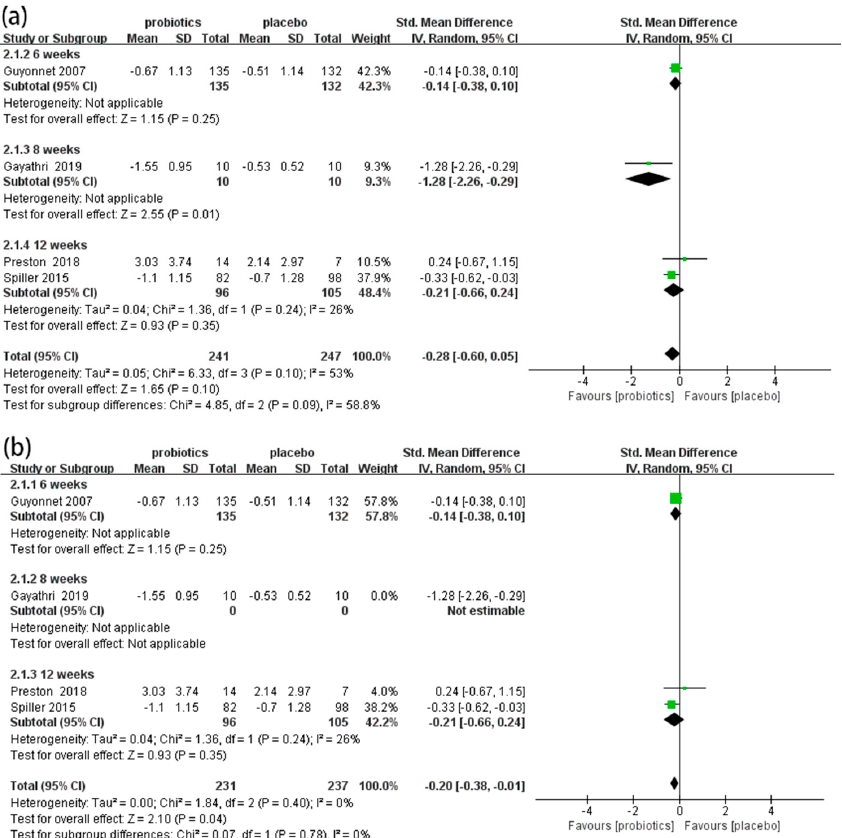
Figure 5. Effect of probiotics on abdominal pain scores in IBS-C patients. ( a ) subgroup analysis for abdominal pain scores; ( b ) sensitivity analysis for abdominal pain scores. The green block represents the effect sizes of individual studies, black diamond block represents the combined effect size.